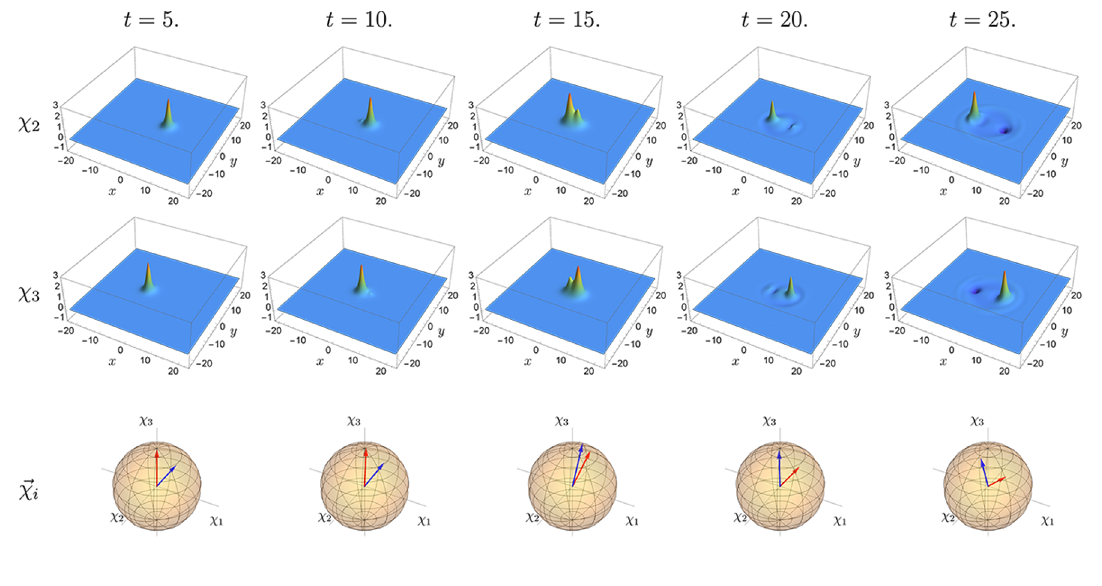
Figure 28 . Snapshots of χ 2 and χ 3 for the head-on collision of type II non-Abelian vortices, with initially orthogonal orientations and initial velocity u = 0 . 5 . The vortices bounce-back due to the type II repulsive force, the orientations dynamically change during and after the scattering. Internal orientations in S 3 are represented in the last